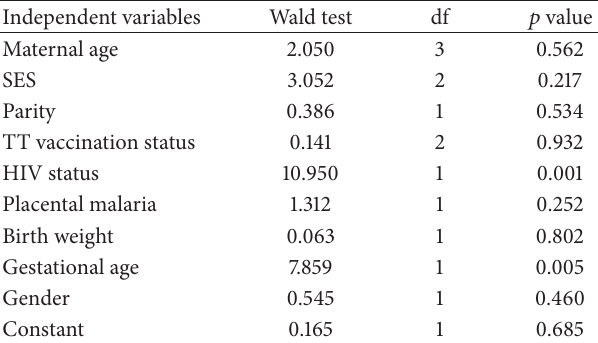
Table 3: Logistic regression analysis results exploring the predictive significance of some maternal and infant factors on cord-blood tetanus antibody